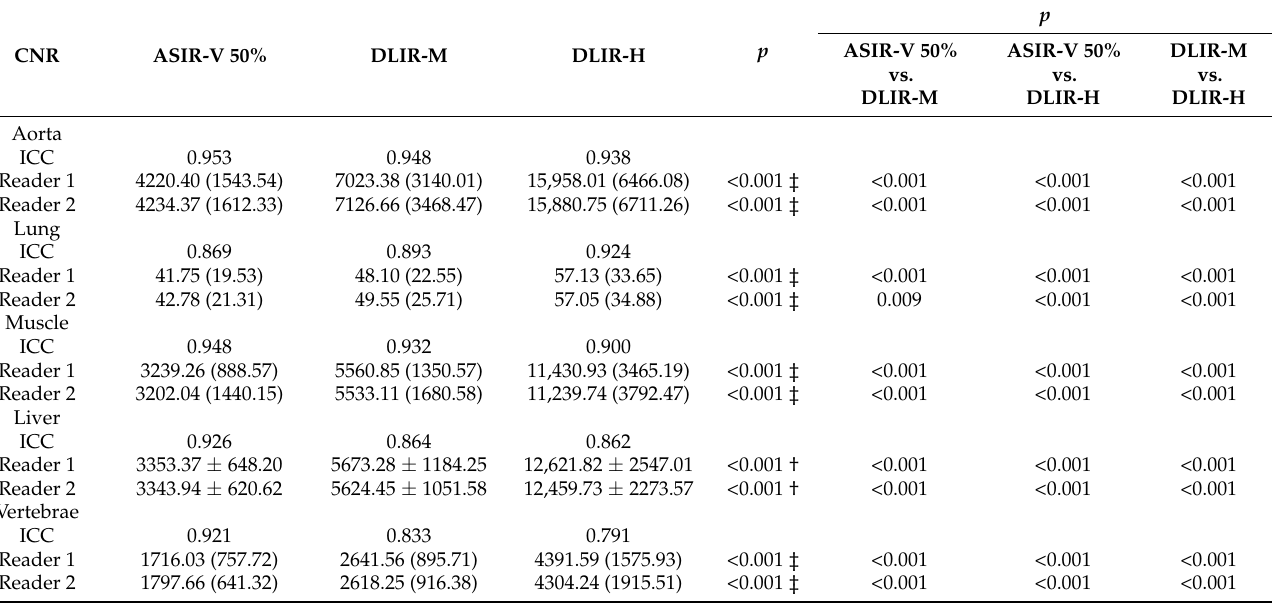
Table 4. Comparison of CNR among the three